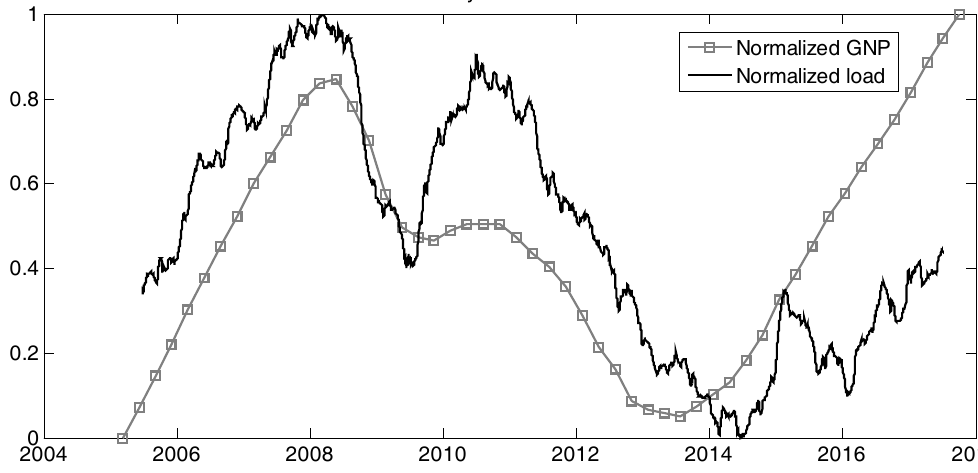
Figure 5. Evolution of 52 weeks moving average load and Gross National Product. Both series are normalized [0, 1].